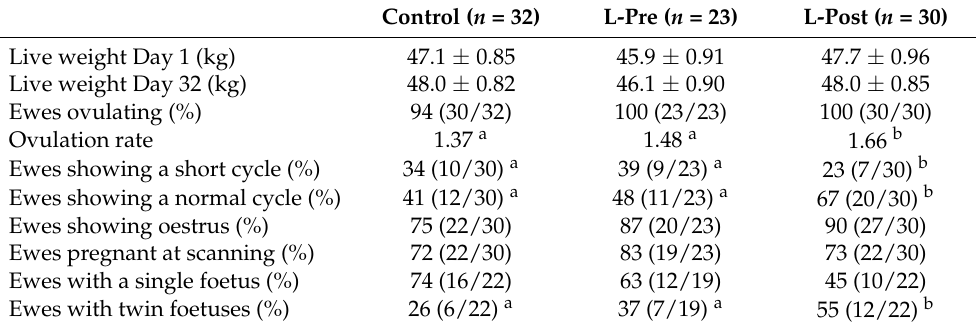
Table 1. Data for Merino ewes induced to ovulate using the “male effect” at the onset of the breeding season. Data for ovarian activity were collected at laparoscopy on Day 15 for L-Pre (lupin supplement fed before the introduction of males) and Day 30 for L-Post (lupin supplement fed after the first male-induced ovulation). Data for pregnancy diagnosis were collected using ultrasound on Day 55 after male-induced ovulation. Different superscripts indicate significant differences ( p <